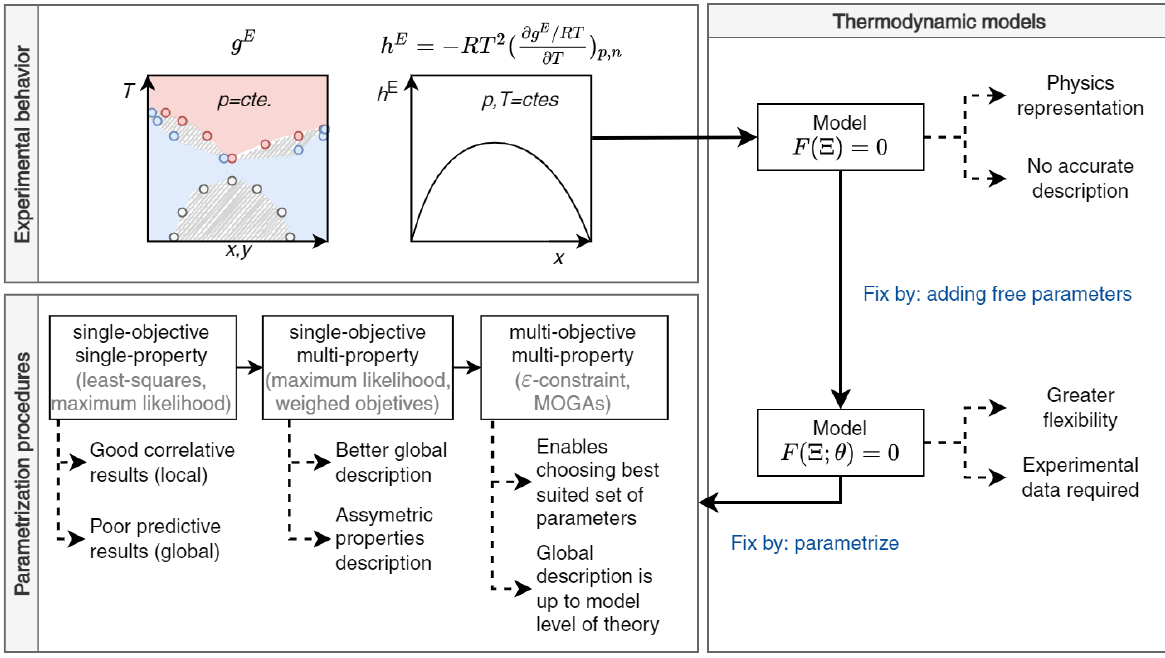
Figure 2. Diagram representing different options to optimize the parameterization of a thermody- namic model.